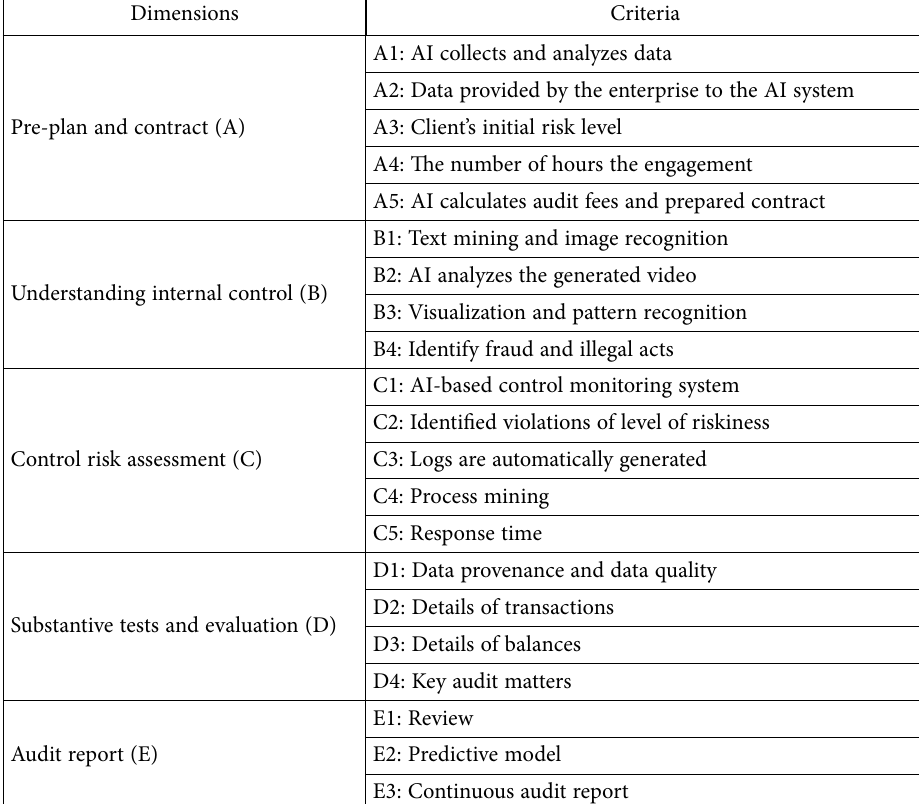
Table 1. Criteria of AI-enabled auditing for the pre-test questionnaire